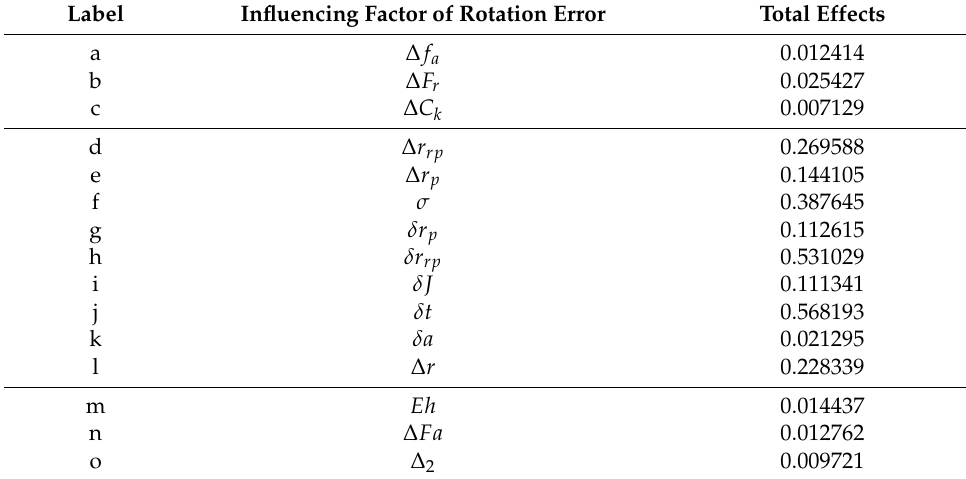
Table 8. The total effects indicators of the reducer rotation error influencing